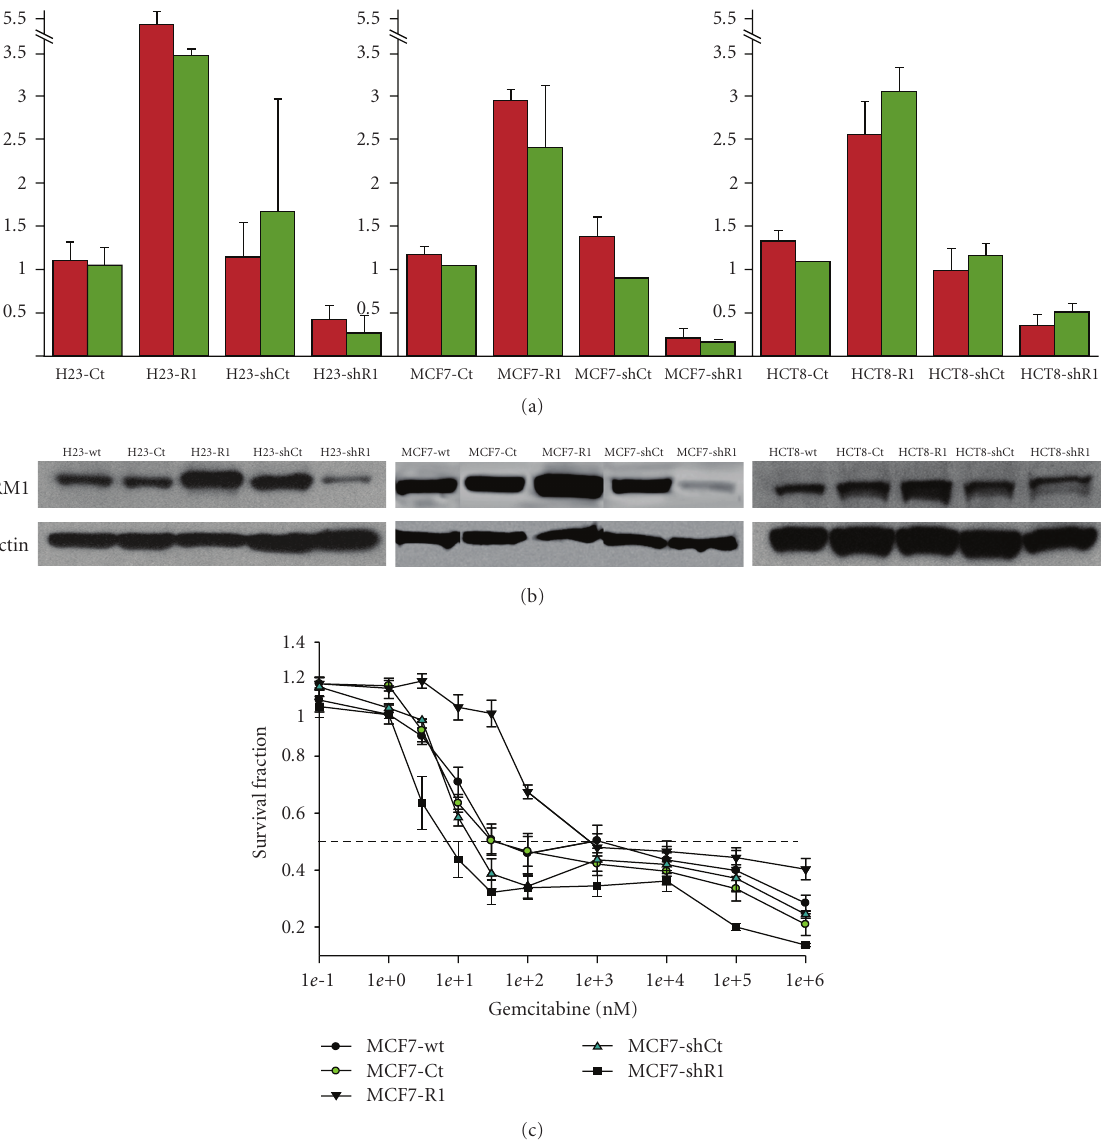
Figure 1: Modification of RRM1 expression by stable transfection with RRM1 and shRRM1 expression vectors in cell lines H23, MCF7, and HCT. Wt, wild-type cell lines, R1, clones of cell lines transfected with RRM1; Ct, clones transfected with an out-of-frame RRM1 vector; shR1, clones transfected with a small hair-pin RRM1 vector; shCt, clones transfected with a random control small hair-pin vector. (a) RRM1 protein (red) and mRNA (green) expression in stably transfected clones of H23, MCF7, and HCT8. (b) Western blots of H23, MCF7, and HCT8 clones. (c) Cytotoxicity of MCF7 clones following gemcitabine treatment for 6 days. Each point is the mean of at least three independent experiments. The dashed line indicates the 50% survival